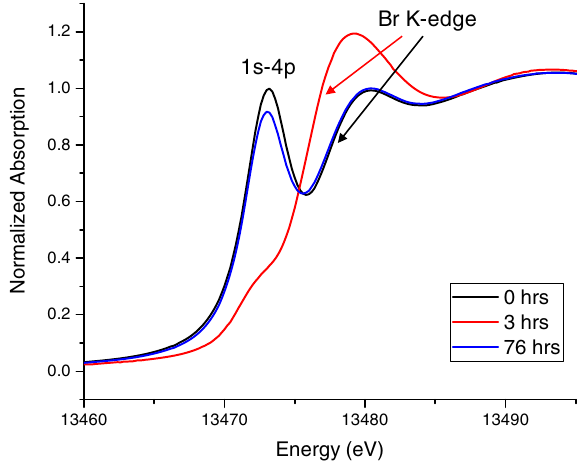
Fig. 3 Bromine K-edge XANES on SFC exposed to HD simulant.